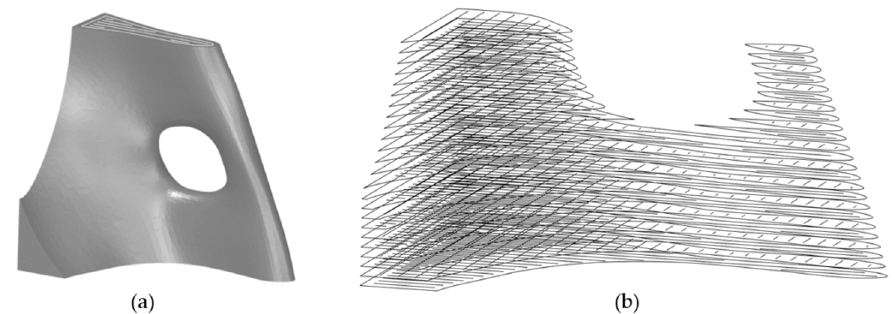
Figure 9. ( a ) Part to be manufactured for the identification of the constraints minimum wall thickness and maximum overhang for 3-axis manufacturing ( b ) generated robot path (first 24 layers) for a layer height of 2.2 mm with a raster + contour filling strategy.